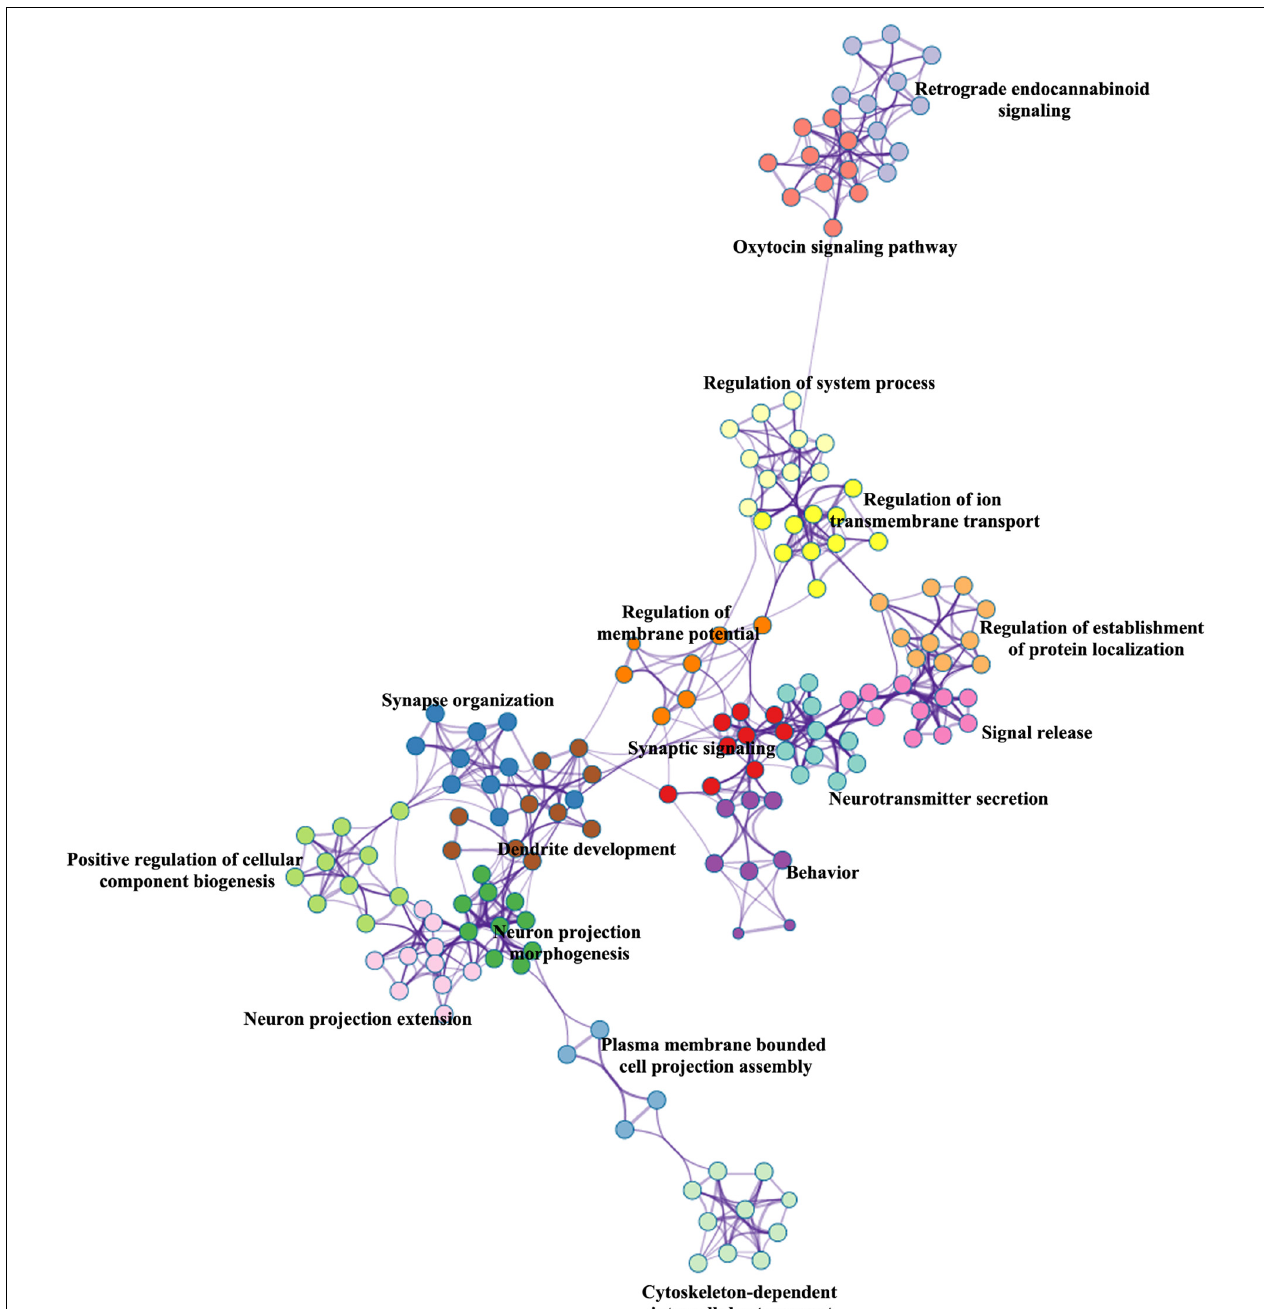
FIGURE 3 | Metascape enrichment network